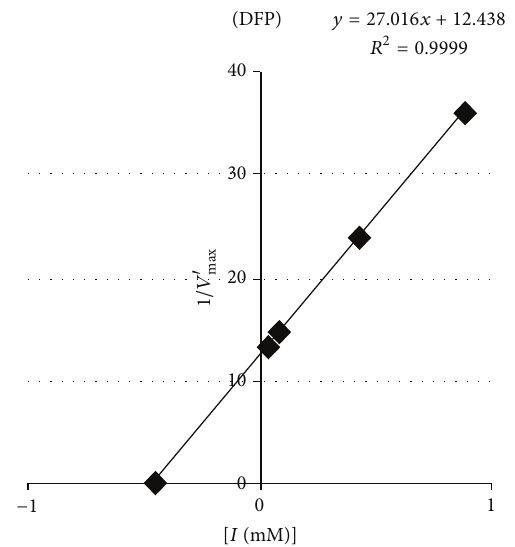
Figure 7: IC50 curve for DFP (the effective concentration of DFP for reducing enzyme activity up to